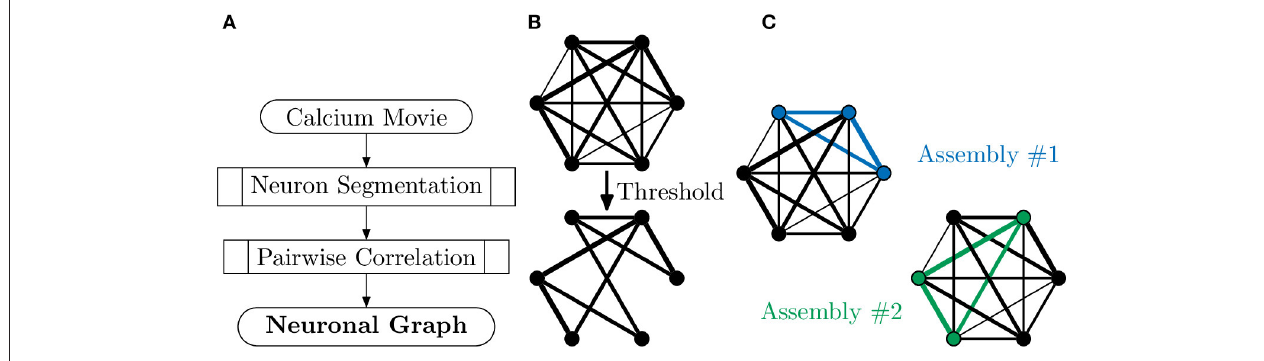
FIGURE 3 | Extracting neuronal graphs from calcium imaging. (A) Well-developed algorithms now allow for automated neuron segmentation from calcium movies. After pairwise correlation with an appropriate metric a graph is extracted. (B) Often neuronal graphs are thresholded based on the pairwise correlation metric used, removing weak and potentially spurious edges; the remaining edges are either unweighted or weighted based on the original metrics. (C) Neuronal graphs can represent whole datasets, e.g., whole-brain calcium imaging, or sub-graphs of neural assemblies, e.g., only neurons activated by a particular stimuli, which may overlap such as in this example (blue and green